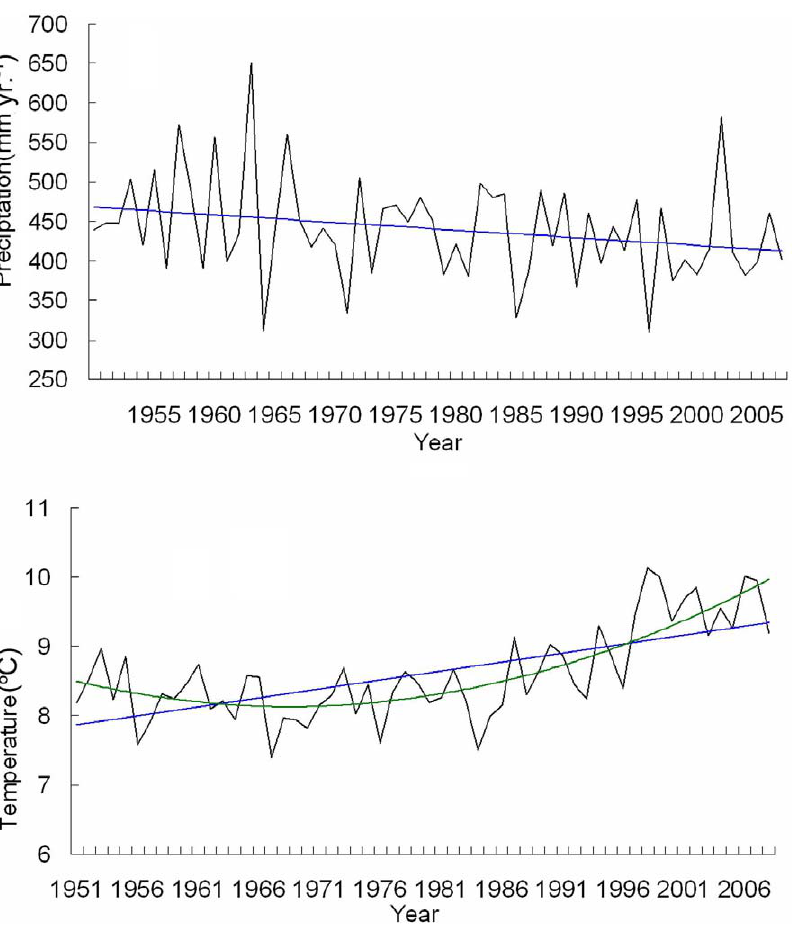
Figure 4. The trend towards a drier and warmer climate in the Loess Plateau region.